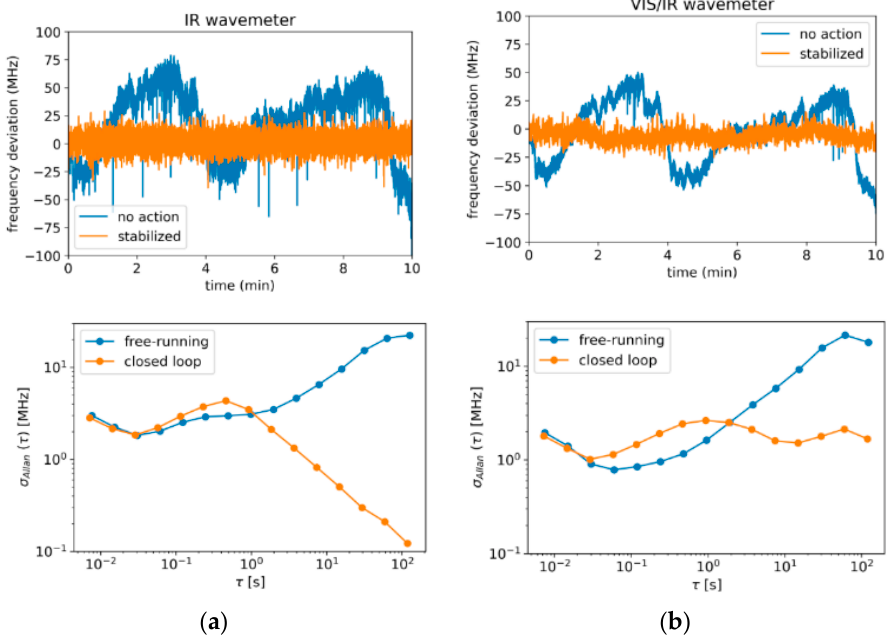
Figure 15. NesCOPO preliminary frequency locking experiments: ( a ) the wavelength measured by the wavemeter used in the control loop; ( b ) the measurement using an independent